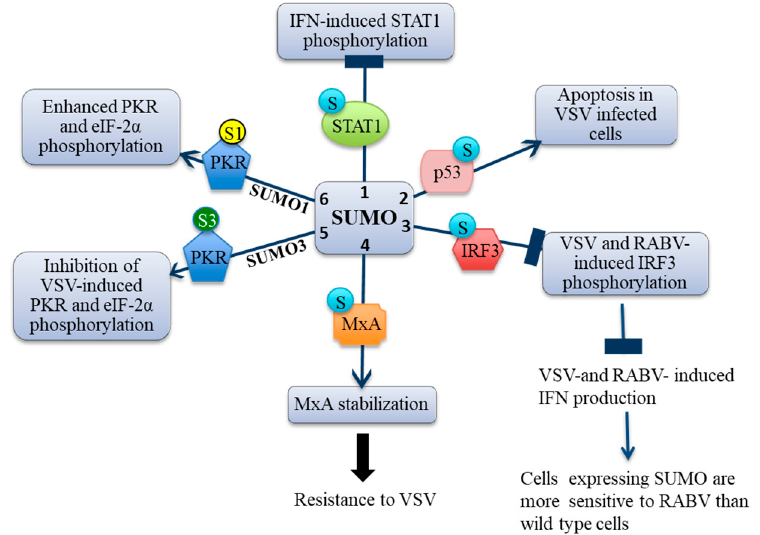
Figure 2. Effect of SUMO on IFN pathways. In SUMO1-expressing and SUMO3-expressing cells: 1. STAT1 activation by IFN stimuli is inhibited by its SUMOylation [3]. 2. p53 SUMOylation is required for the induction of apoptosis in VSV infected cells [25]. 3. IRF3 is SUMOylated, which causes an inhibition of VSV-induced and RABV-induced IFN synthesis. This results in a higher RABV replication [2]. 4. SUMOylation of MxA in SUMO-expressing cells leads to MxA stabilization and to increased resistance to VSV infection [2]. 5, 6. SUMO1 (S1) and SUMO3 (S3) have different effects on PKR and eIF-2 α activation [9].